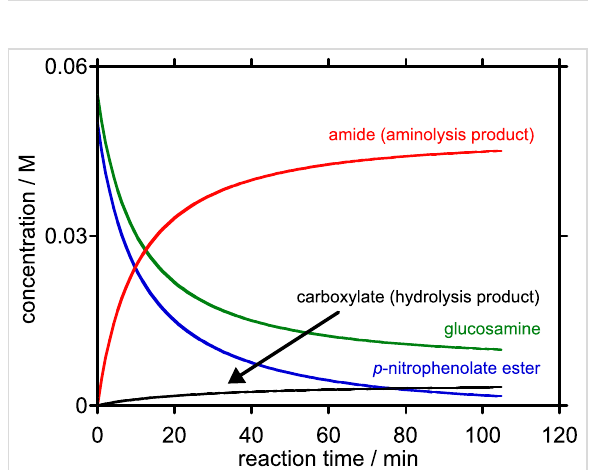
Figure 4: Predicted concentration-time profile for the reaction between starting concentrations of 0.05 M m -nitrophenyl ester 7 (R = m NP) and 0.055 M D-glucosamine at pH 7.46, 25 °C to 99% consumption of m -nitrophenyl ester 7 (R = m